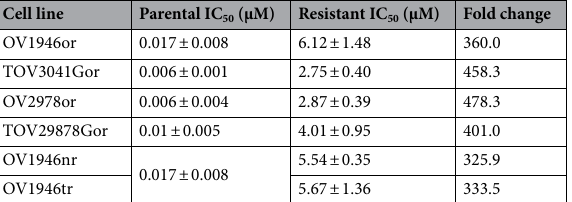
Table 1. Detailed olaparib IC 50 values of acquired resistance cell lines. Experiments were repeated three